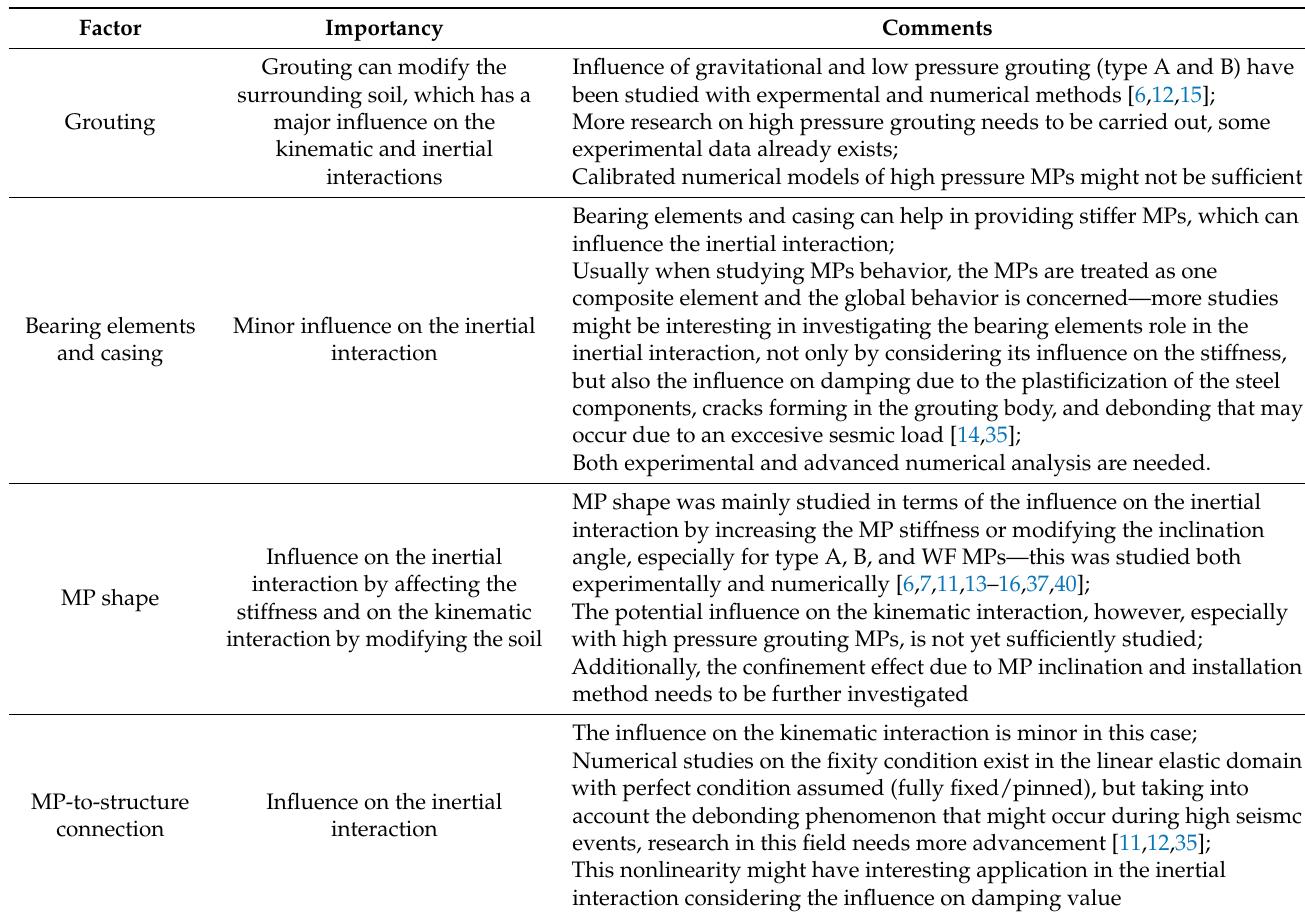
Table 5. Factors influencing the seismic behavior—synthesis from